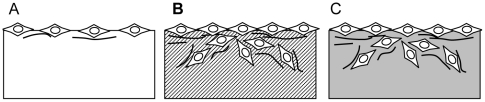
Schematic illustration of the results.A) Periodontal ligament fibroblasts on the peptide scaffold RADA16, B) on the functionalized peptide scaffold PRG and C) on the functionalized peptide scaffold PDS. In case of the functionalized peptide scaffold PRG and PDS, periodontal ligament fibroblasts showed cell proliferation, migration into the scaffolds and type I and type III collagen productions required to regenerate periodontal ligament.